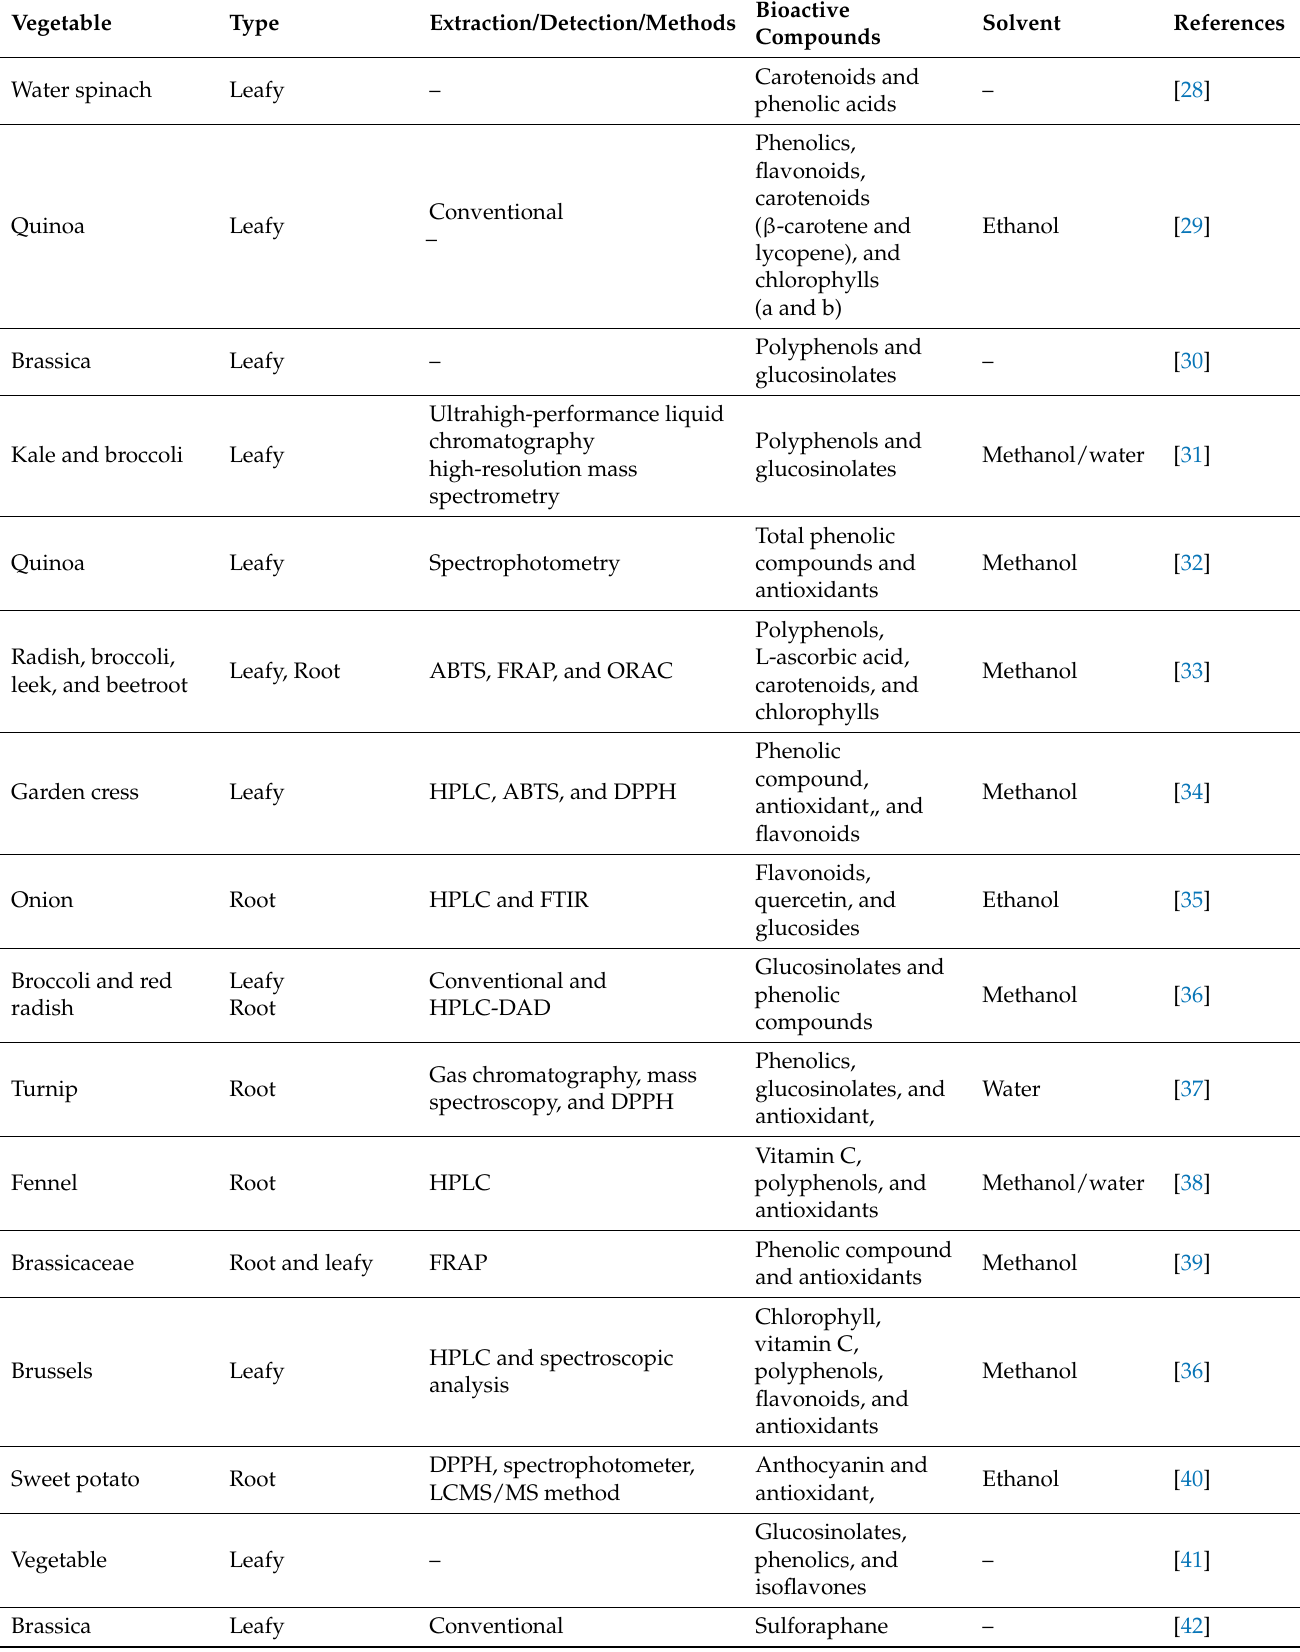
Table 1. Extraction of bioactive compound from vegetables